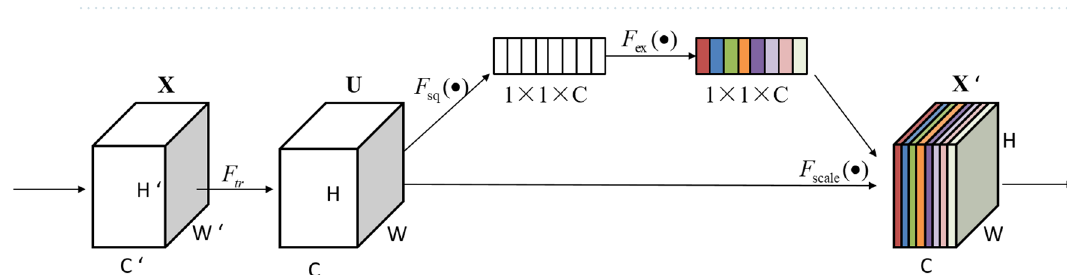
Figure 2. Recognition network structure.